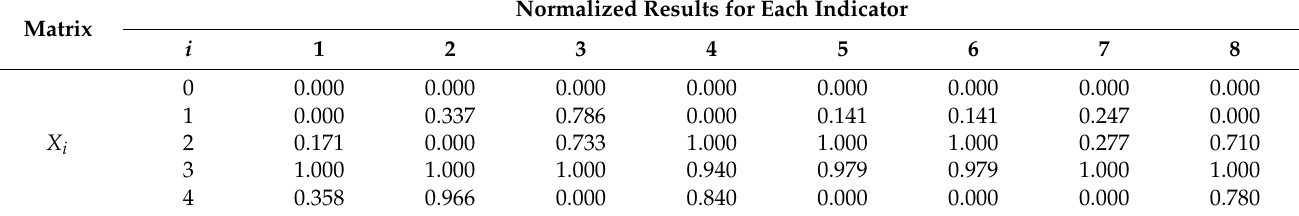
Table 19. Normalization